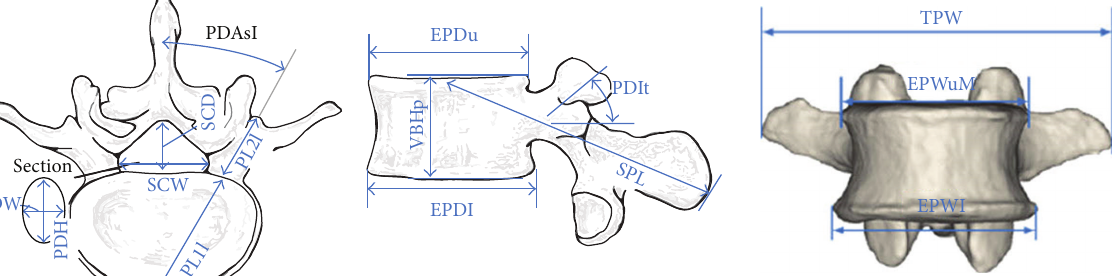
Figure 6: Geometry data related to lumbar vertebras.